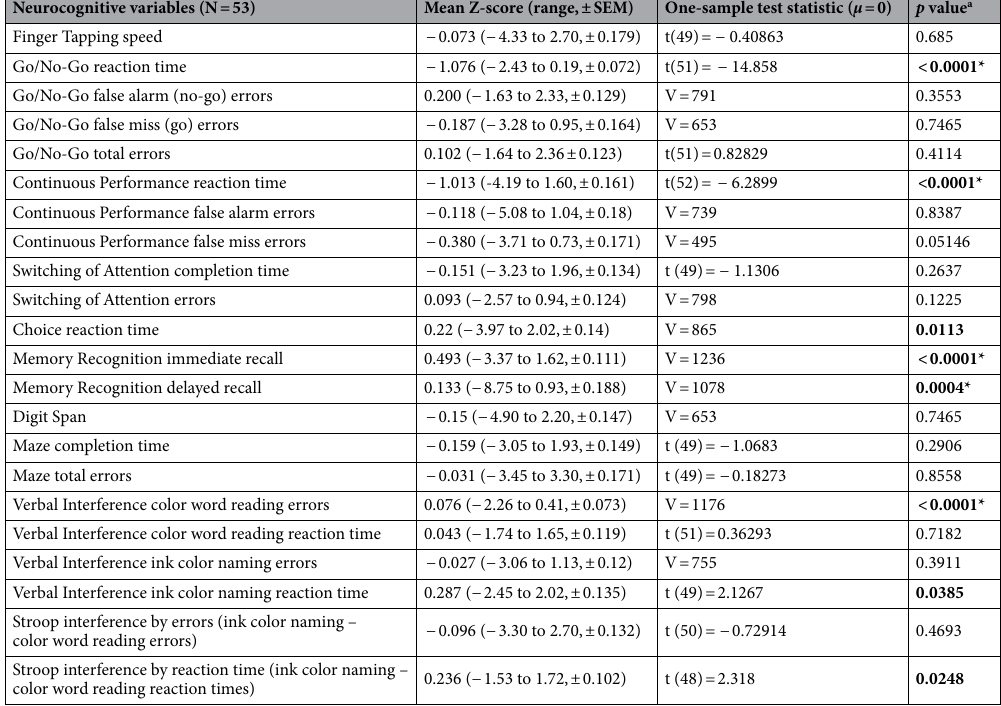
Table 3. Neurocognitive performance of hoarding disorder participants relative to normative population. a p values < .05 are indicated in bold text. *Meets Bonferroni-corrected alpha threshold for statistical significance of p < 0.003.